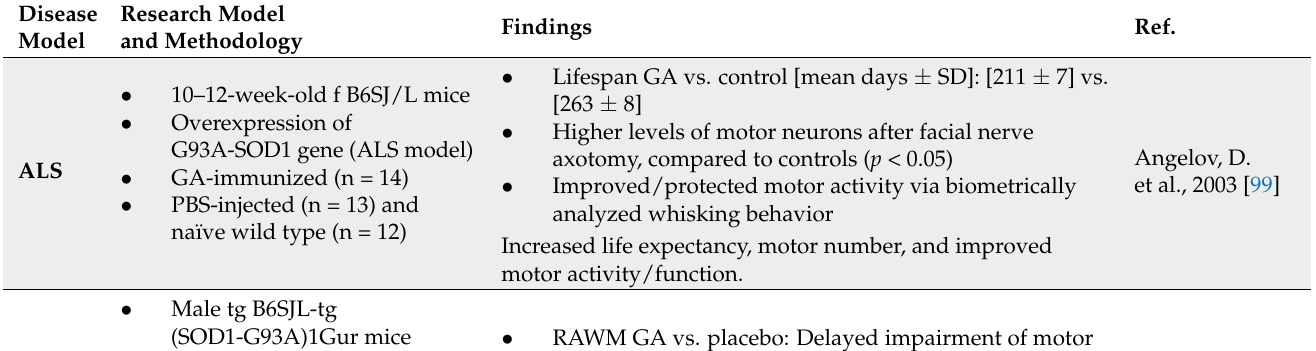
Table 5. Animal Studies Examining Alternative Uses of Glatiramer Acetate in Amyotrophic Lateral